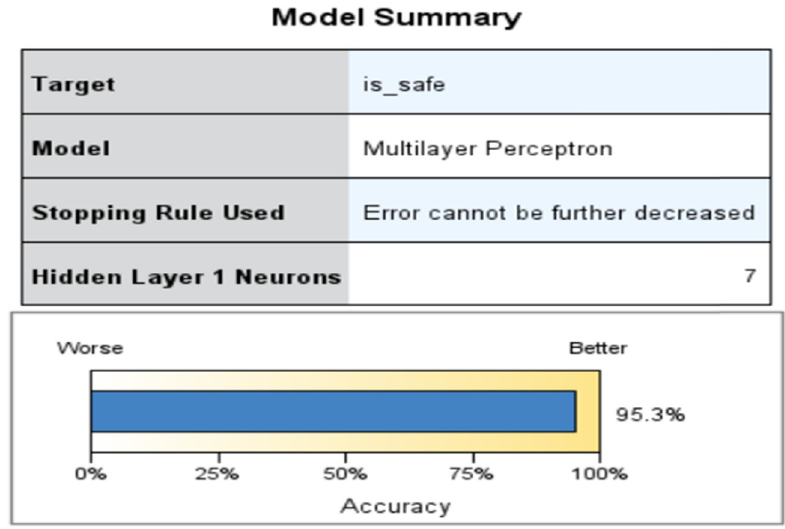
Figure 3: MLP details for water quality